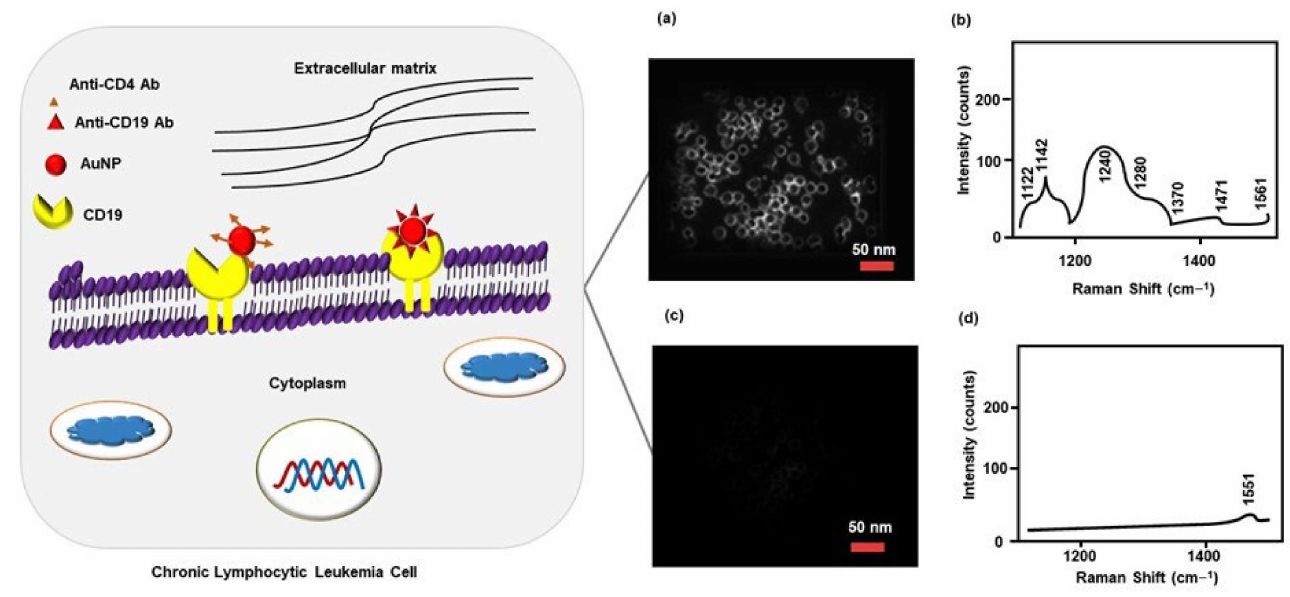
Figure 4. Detection of chronic lymphocytic leukemia using gold nanoparticles. Dark-field images ( a ) and accompanying Raman spectra ( b ) of Giemsa and anti-CD19 Ab-conjugated AuNPs stained CLL cells. Giemsa-stained CLL cells were not visualized after anti-CD4 Ab containing AuNPs treatment in the dark-field ( c ), and no peak was detected by Raman spectroscopy ( d ). These images indicate possible results, but do not reflect any actual experiments. Chronic lymphocytic leukemia: CCL; Cluster of differentiation: CD; Antibody: Ab; Gold nanoparticles: